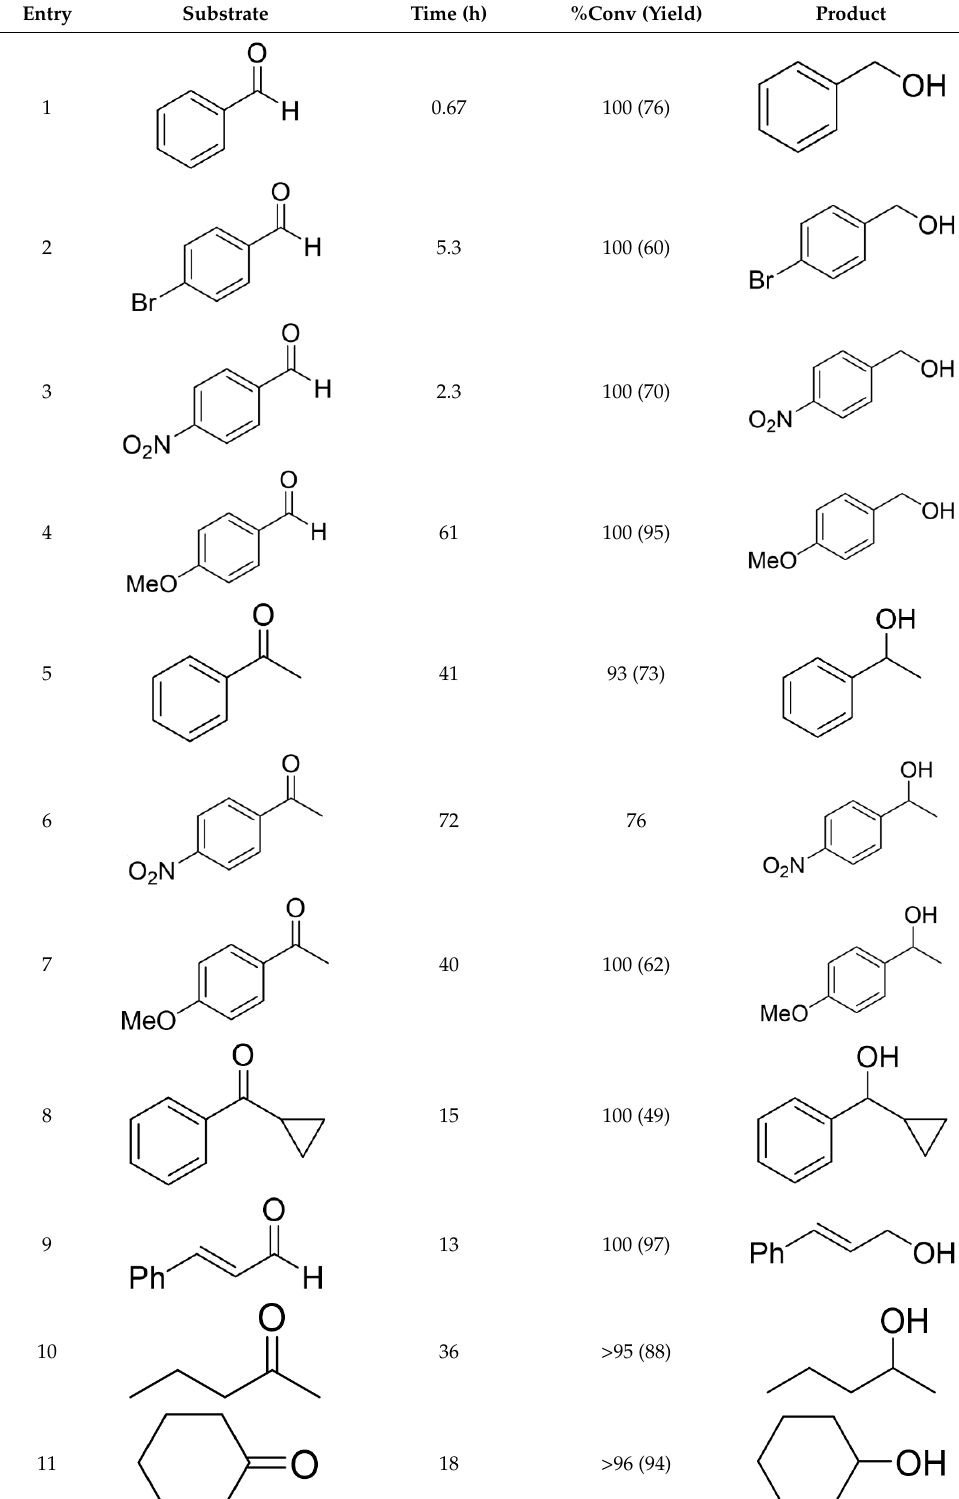
substrates also underwent hydrosilylation reactions under the same conditions (entries 10-11), and the conversions were generally high (>95%). Table 2. Hydrosilylation of Aldehydes and Ketones Catalyzed by (salan)MnN 3 a . Entry Substrate Time (h) %Conv (Yield) Product 1 1 0.67 1